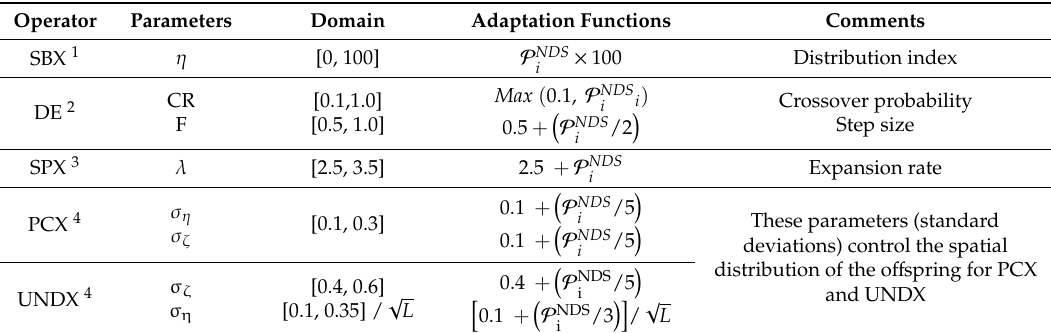
Table 1. Parameters control formulae in epsilon-dominance-driven self-adaptive evolutionary algorithm ( ε